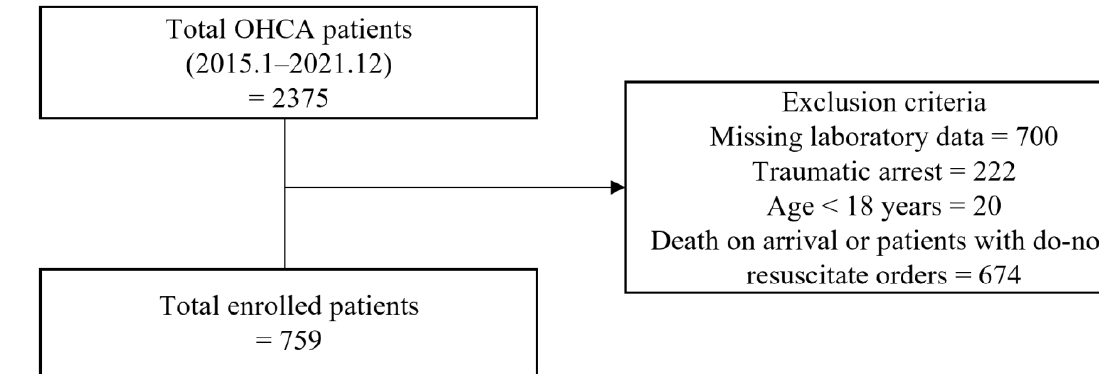
Figure 1. Flowchart of patient screening and selection during the study enrollment process. OHCA, out-of-hospital cardiac arrest. Table 1. Baseline characteristics of